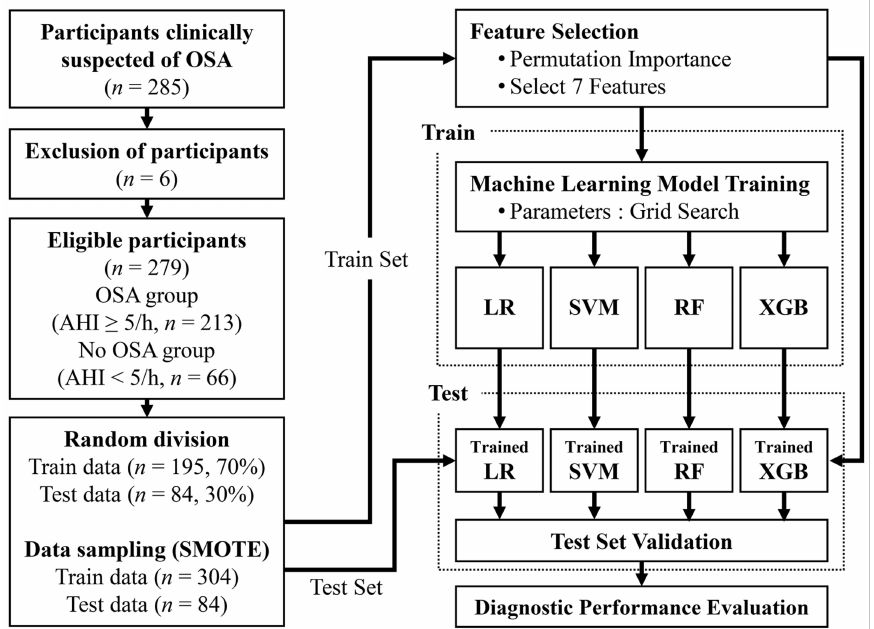
Figure 1. Flowchart of obstructive sleep apnea (OSA) data collection and analysis. Train data: OSA ( n = 149), no OSA ( n = 46); Test data: OSA ( n = 64), no OSA ( n = 20). OSA, obstructive sleep apnea; AHI, apnea–hypopnea index; CV, cross-validation; SMOTE, synthetic minority oversampling